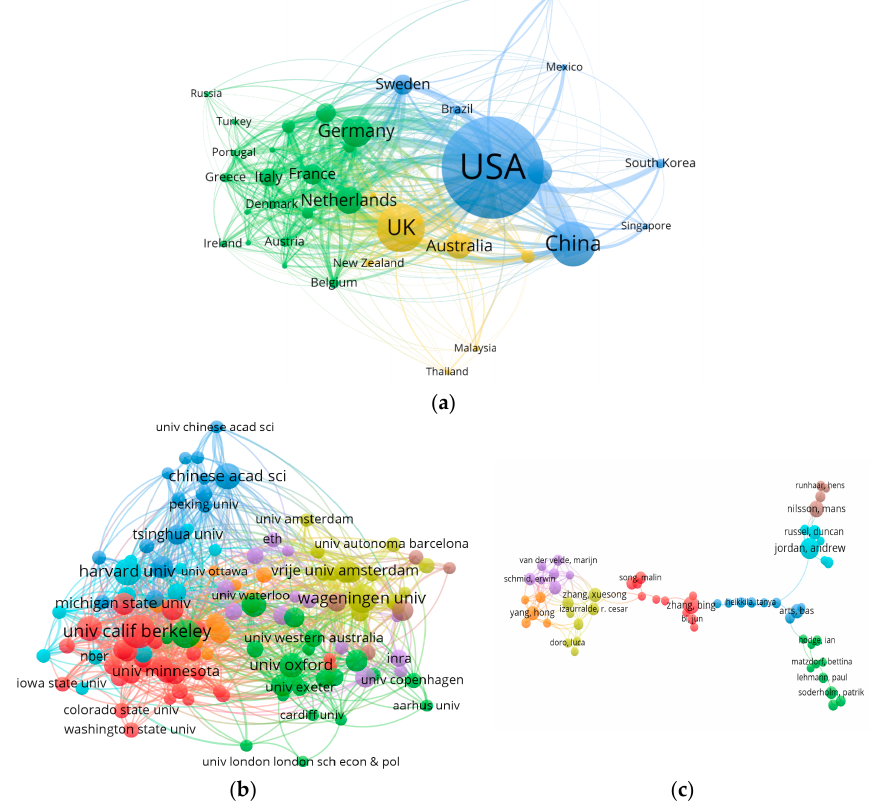
Figure 6. Collaboration network in research on environmental regulation from 2000 to 2019. ( a ) International collaboration network; ( b ) Institutional collaboration network; ( c ) Authorial collaboration network.